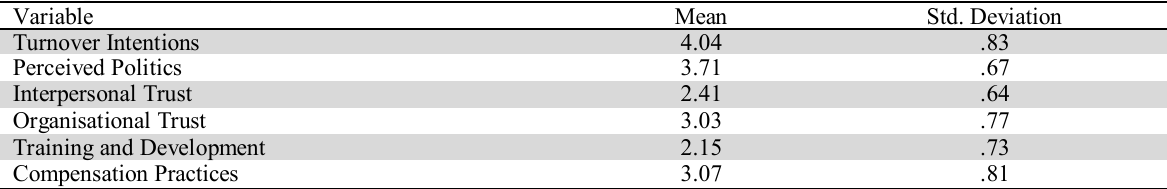
Descriptive Statistics of the Study